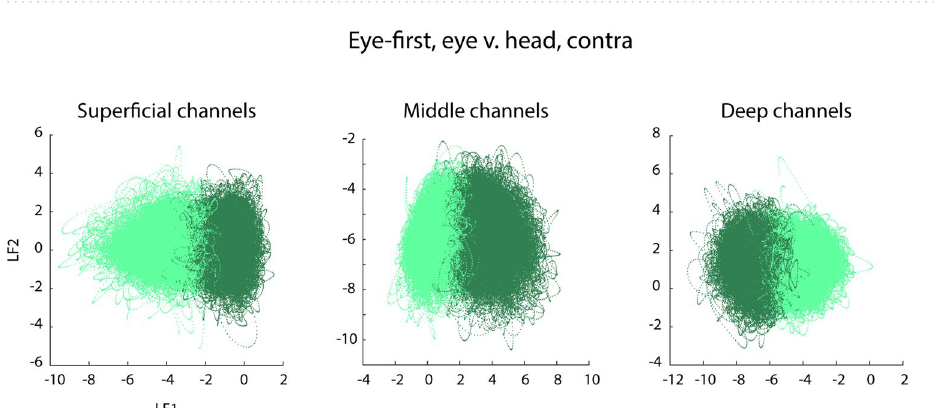
Figure 10. LDA analysis of eye vs head neural activity separated by relative cortical depth. Left subplot shows data from superficial layers, center subplot: middle layers, and right subplot: deep layers. We see that the quality of separation between the two parameters does not appreciably change based on the cortical